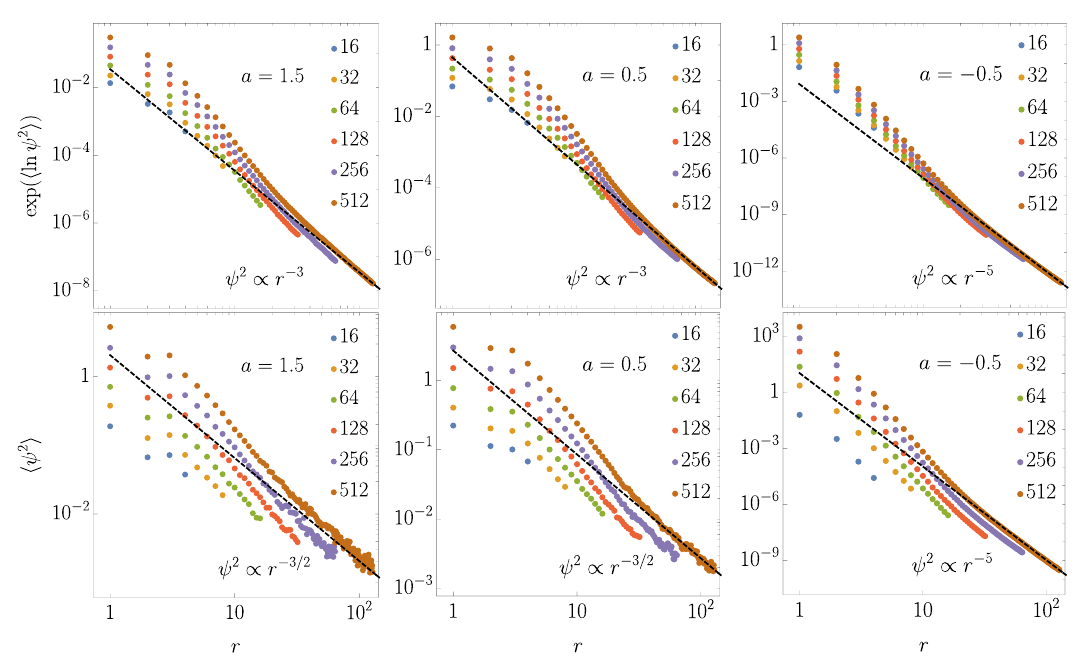
Figure 4: The spatial decay of mid-spectrum eigenstates in PLE model. (Up- ( r ) = 〈 ln ψ 2 ( r ) 〉 and (Lower row) mean 〈 ψ 2 ( r ) 〉 wave- per row) typical ln ψ 2 nm m m n n typ function power-law decay for several powers a (shown in labels) and cutoffs R (shown in legend). All points are averaged over 10 3 disorder realizations and shifted vertically for clarity. Dashed lines show analytical predictions, Eqs. (10) and (11) (written in panels as equations). The right column shows that the validity of RG scheme for typical wavefunction decay can be extended also to some spatially in- creasing (though unphysical) hopping.